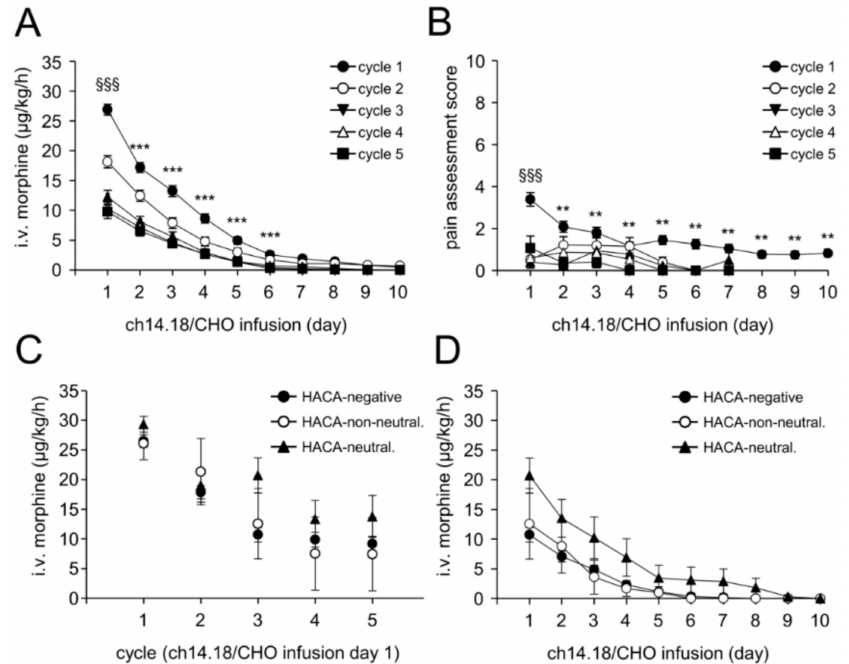
Figure 6. Intravenous morphine usage and pain assessment. Ch14.18/CHO-dependent pain